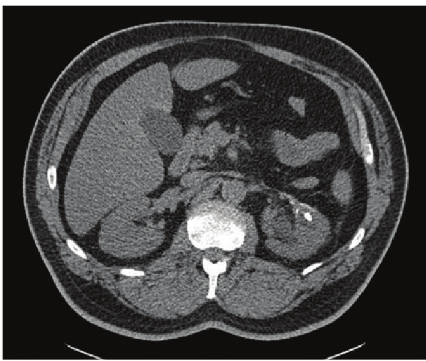
Figure 1: Noncontrast helical abdominal CT scan showing per- sistent 10 mm left renal calculus after extracorporeal shock wave lithotripsy.